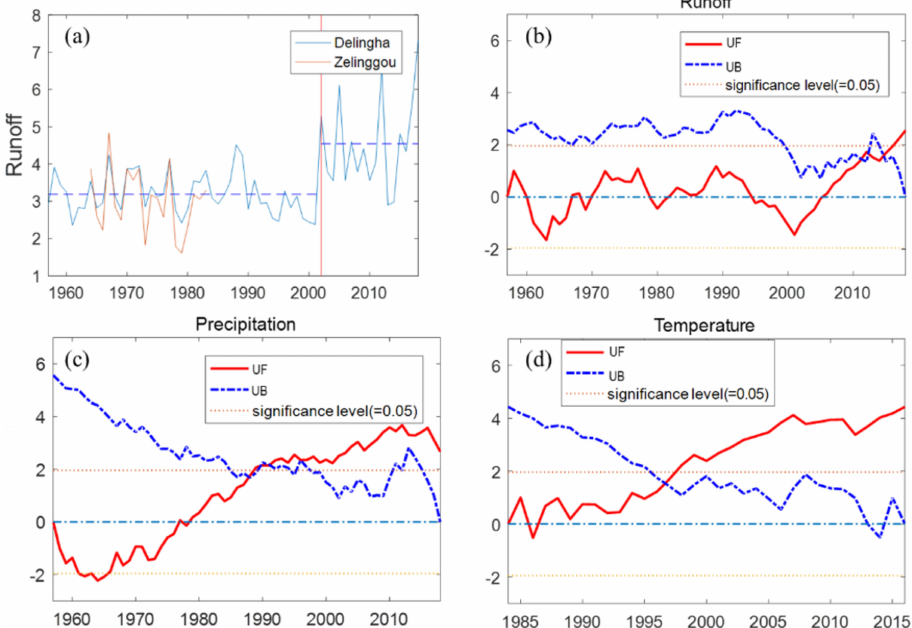
Figure 5. Plots depicting the change of runoff at Delingha and Zelinggou stations ( a ), results of MK test for runoff ( b ), precipitation ( c ), and temperature ( d ) at Delingha station.